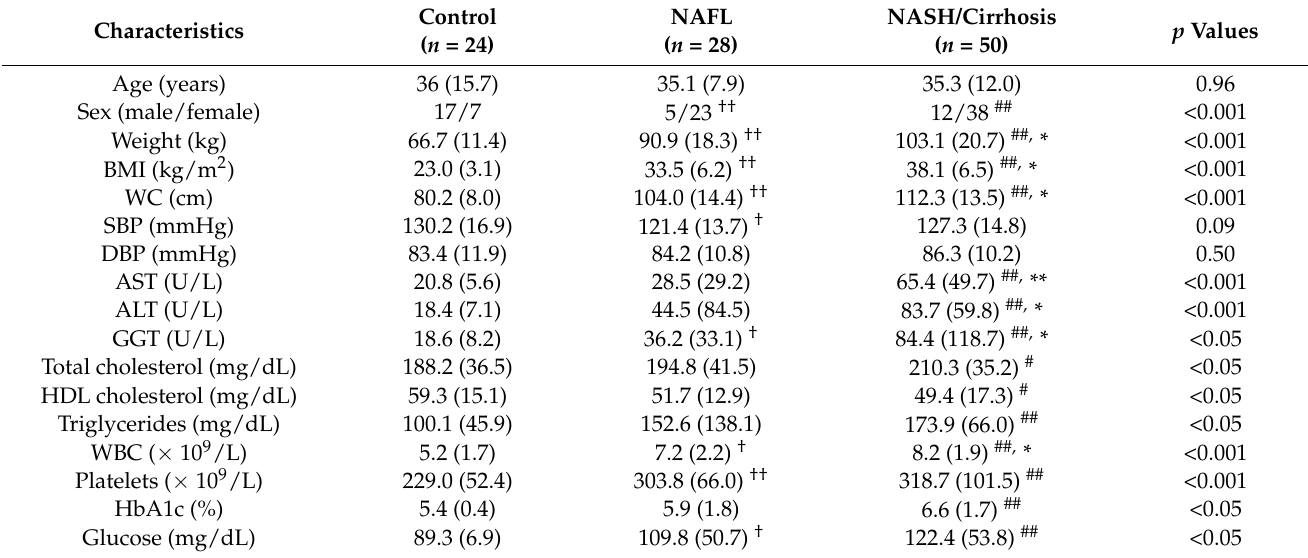
Table 1. Demographic and clinical characteristics of the study